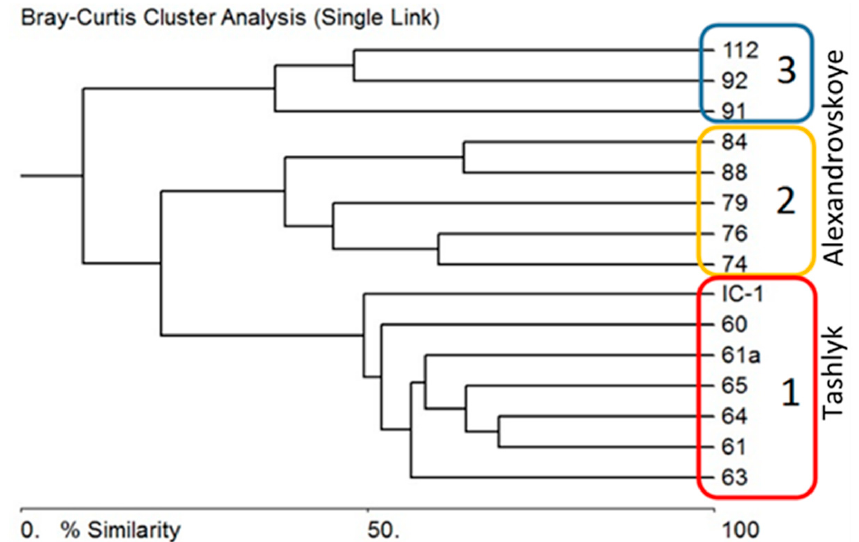
Figure 4. Tree of similarity of the communities of the Tashlyk and Alexandrovskoye reservoirs based on the abundance of phytoplankton LIT by stations. The clusters are outlined with colored outlines.